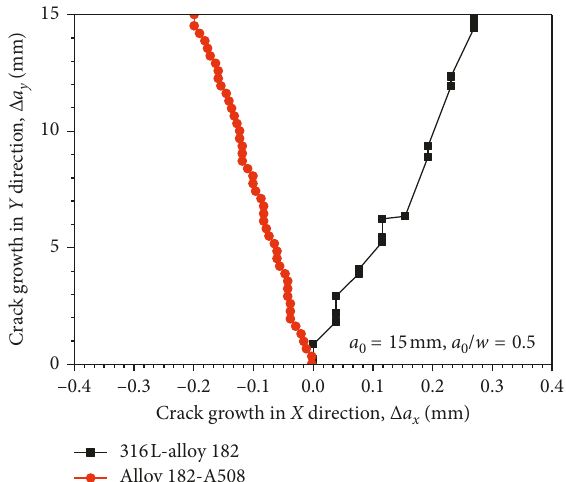
Figure 16: Crack extension paths at different interfaces of DMW joints.